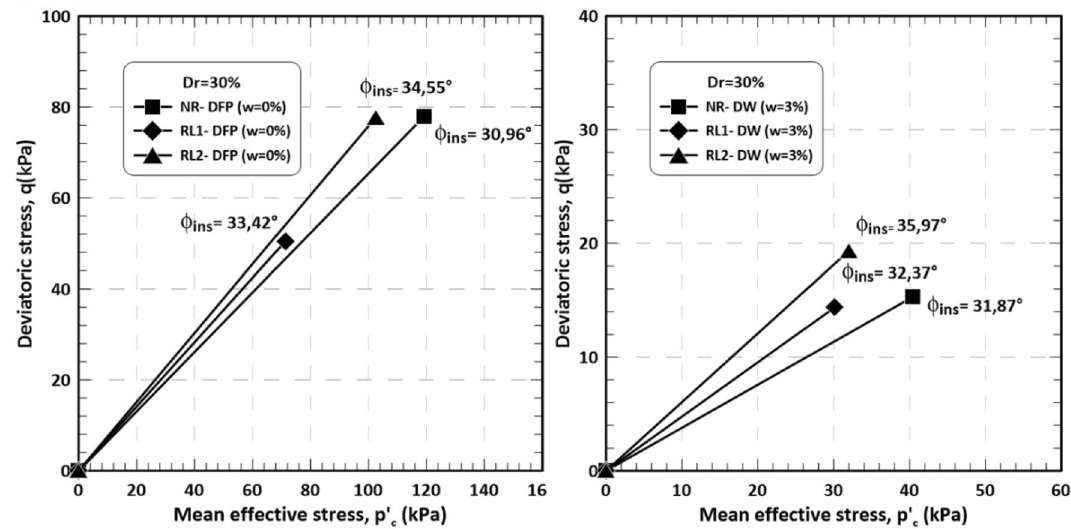
Fig. 15 Instability lines of unreinforced and reinforced sand prepared by DFP and WD